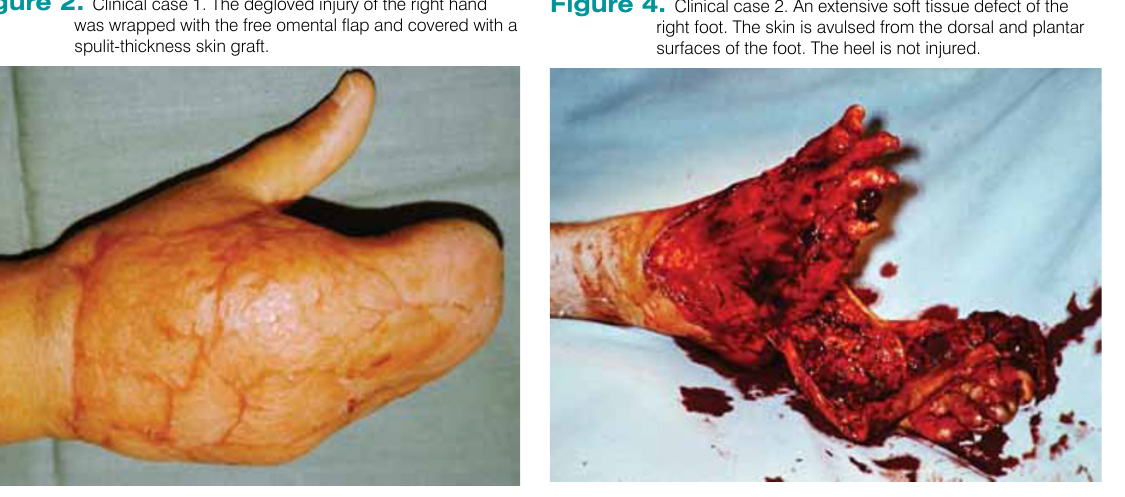
Figure 3. Clinical case 1. One year after the injury. The patient‘s hand after fi nger-separating surgeries.